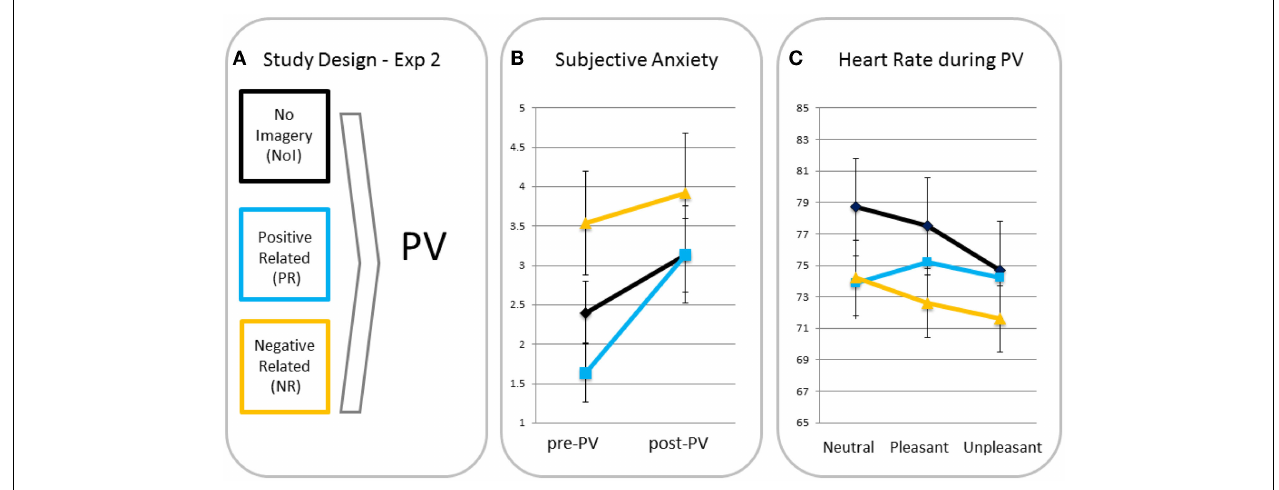
FIGURE 2 | Study design (A), subjective anxiety pre- and post-passive viewing [PV; (B)] and heart rate in response to neutral, pleasant, and unpleasant pictures (C) for participants in the no imagery (NoI), positive related (PR), and negative related (NR) script condition .